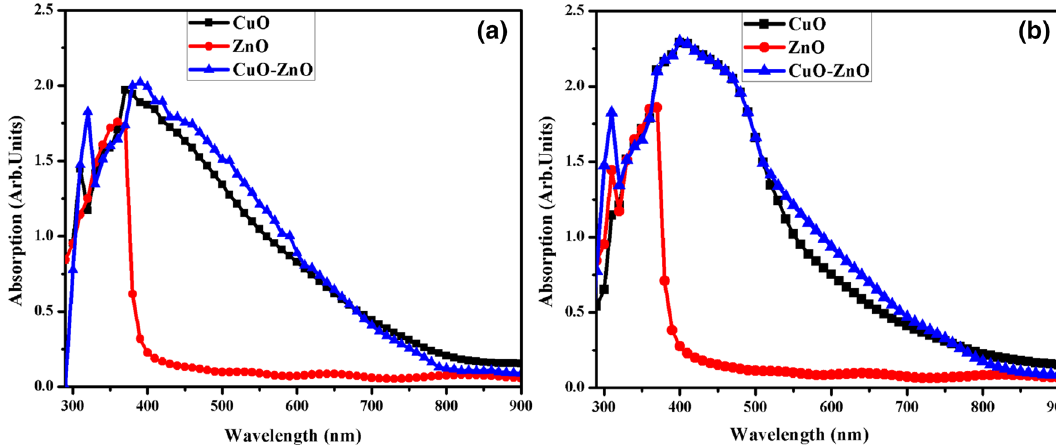
Fig. 3 UV–Vis absorption of distinct and bilayer films at 400 °C ( a ) and at 500 °C ( b